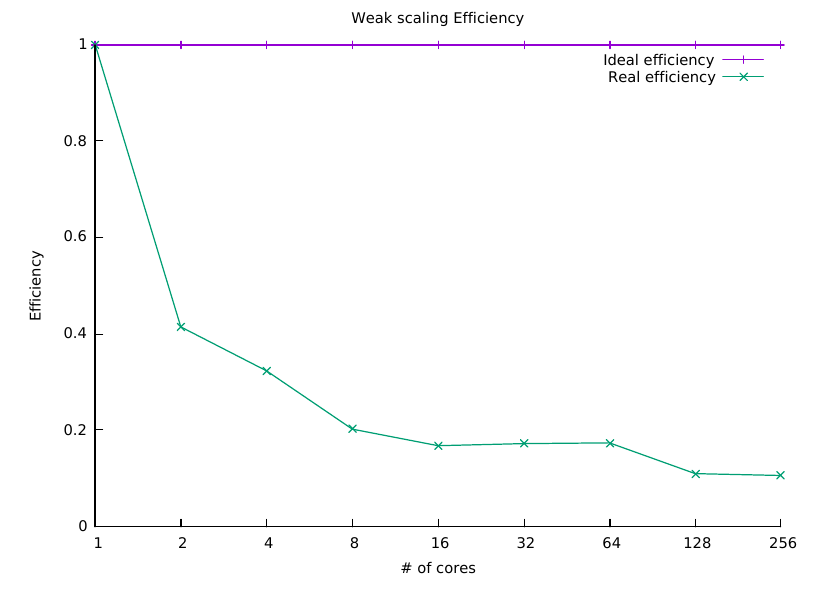
Figure 4. Weak scaling